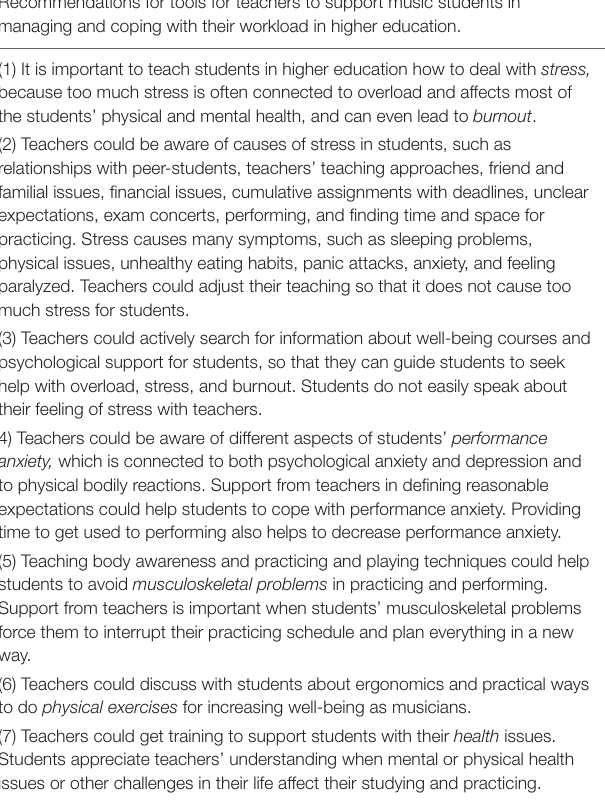
TABLE 6 | Music students’ psychological and physiological issues and tools for